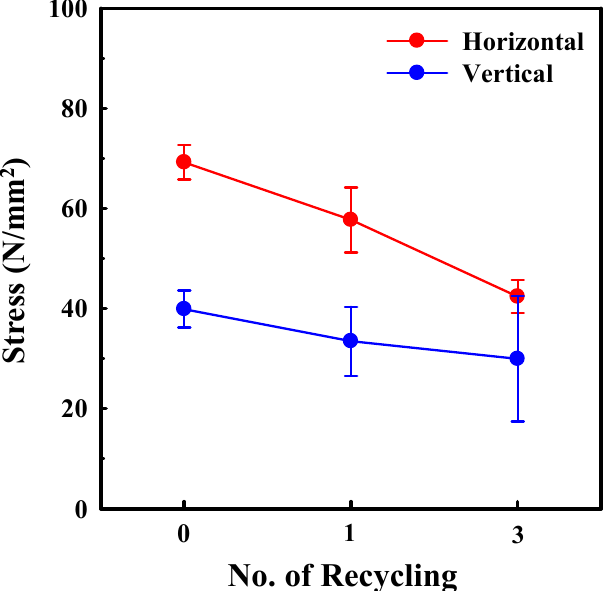
Figure 5. Averaged ultimate tensile strength as a function of the number of recycling steps for both horizontally and vertically fabricated specimens.